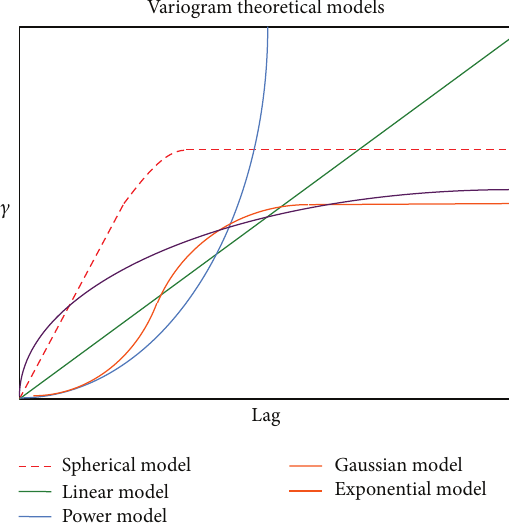
Figure 3: Most common theoretical model